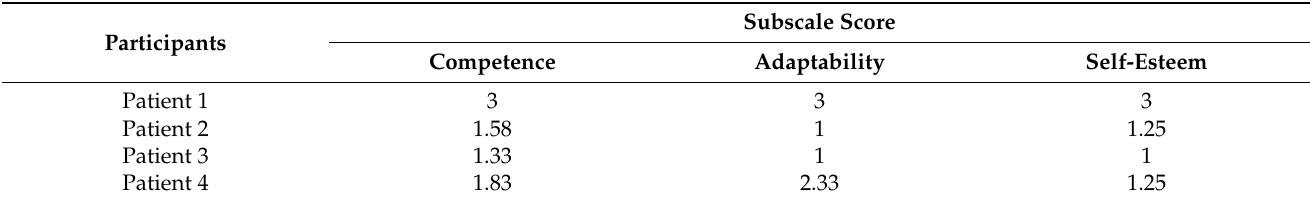
Table 5. Summary of Psychosocial Impact of Assistive Devices Scale